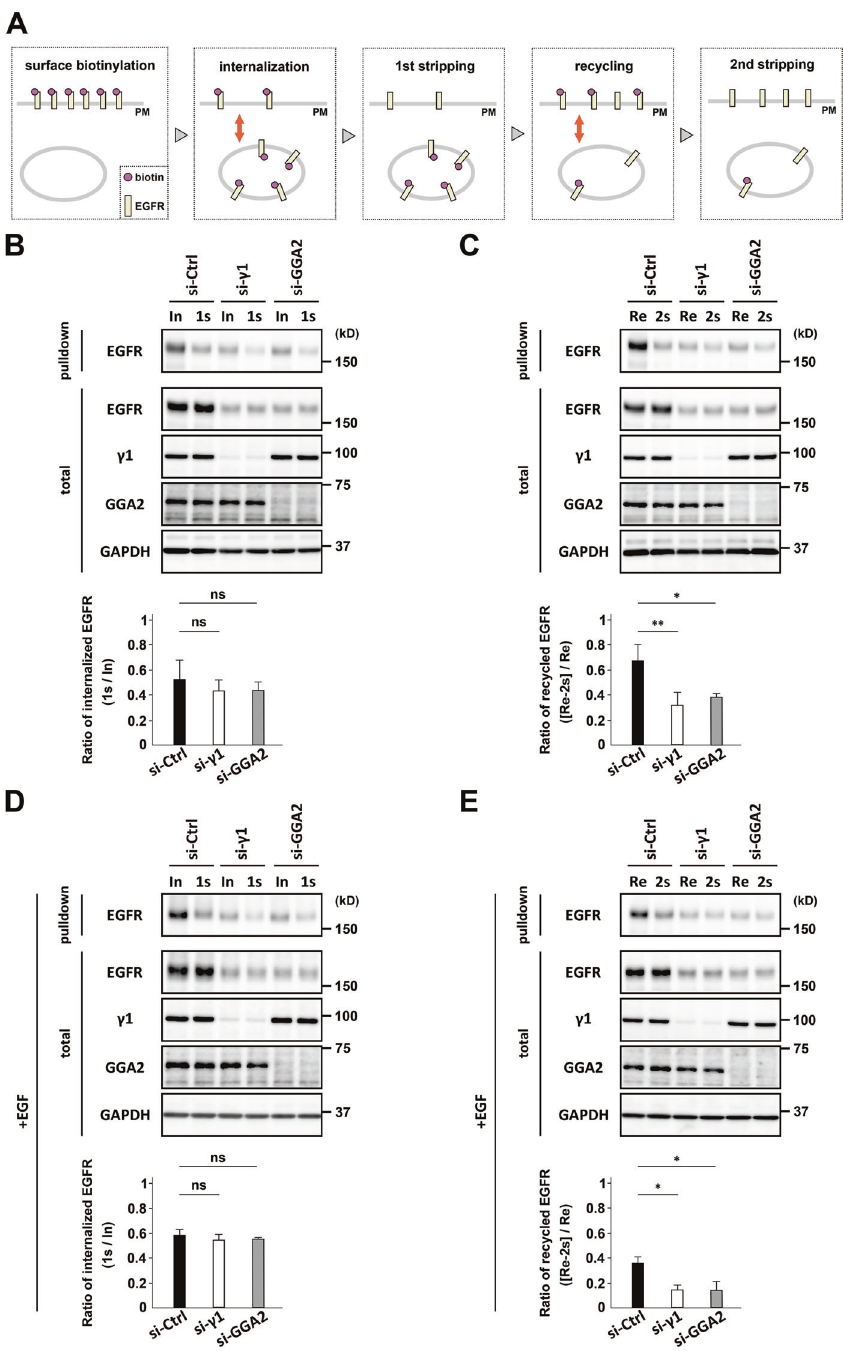
Fig. 5 AP-1 and GGA2 support EGFR recycling back to the PM. A Schematic description of the EGFR recycling assay. Serum starved cells were labeled with Sulfo-NHS-SS-biotin (pink circle, surface biotinylation), and incubated with DMEM for 30 min at 37 °C ( B and C ), or DMEM containing 10 nM EGF for 10 min at 37 °C ( D and E ) for internalization. Afterward, cells were treated with a reducing reagent to remove biotin from EGFR (yellow bar) on the PM (1st stripping). Cells were re-incubated with DMEM at 37 °C for 30 min to allow recycling of